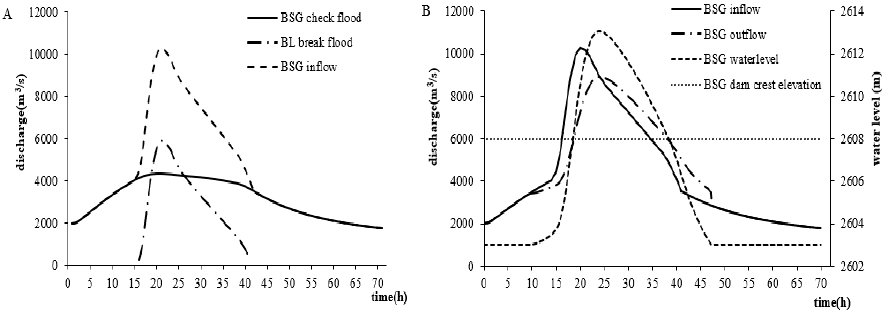
Figure 12. ( A ) The BL break flood encounters BSG check flood; ( B ) the regulated flood progress of BSG.